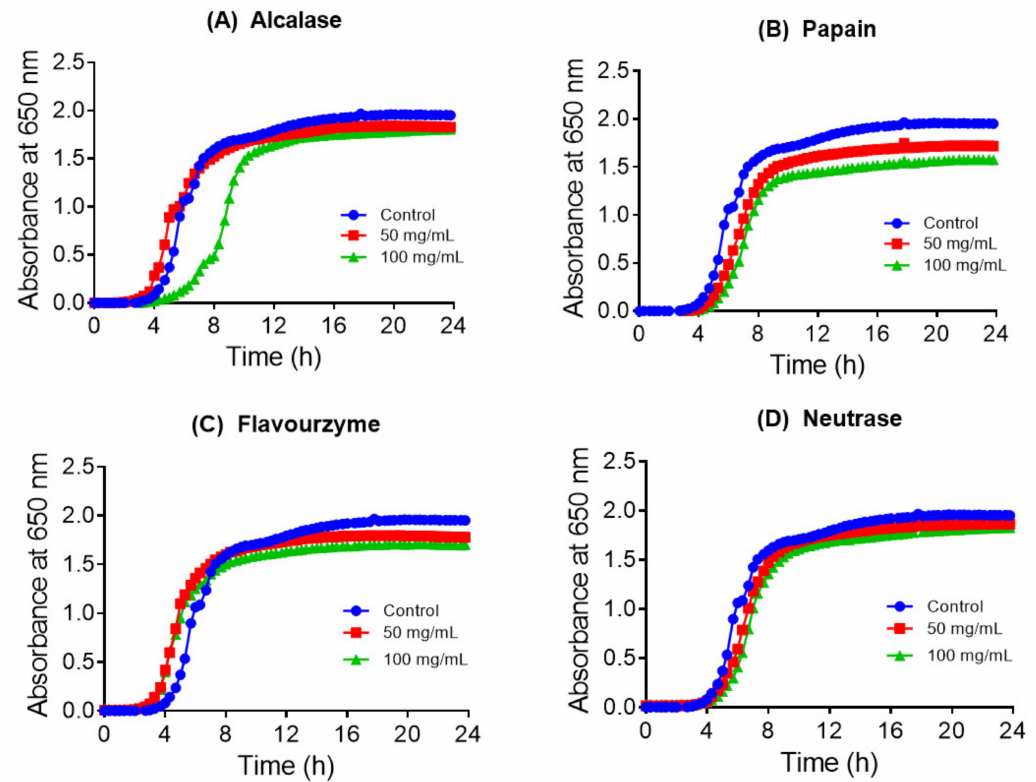
Figure 2. Growth curves of E. coli in the absence (control) and presence of collagen hydrolysates produced with four enzymes ( A ) Alcalase, ( B ) papain, ( C ) Flavourzyme, and ( D ) Neutrase. Experiments were conducted three times, and each data point represents the mean